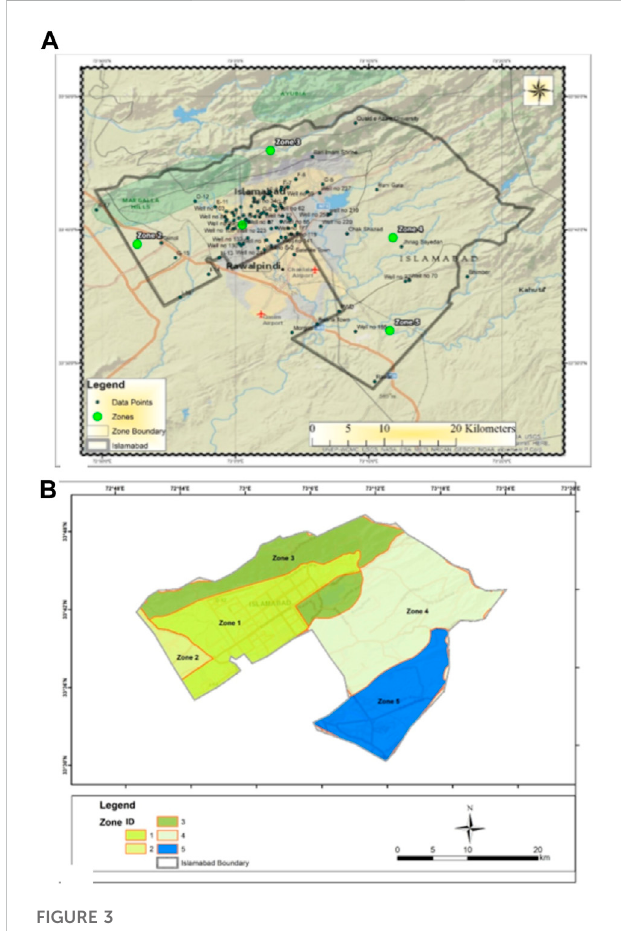
FIGURE 3 (A) Well points location map of the study area. (B) Zonation map of